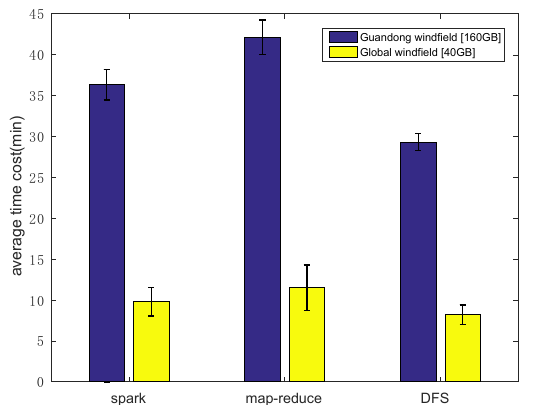
Figure 10. Average total time consumption comparison under different frameworks. The performance of DFS was obviously better than that of mainstream computing framework when calculating massive vector